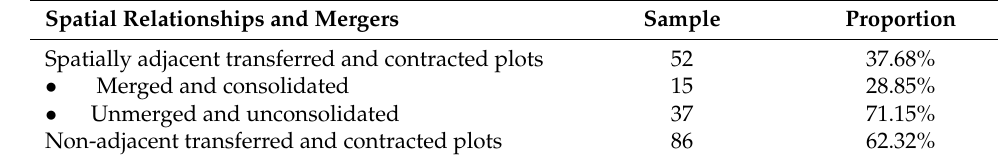
Table 3. Spatial relationships and mergers between transferred and contracted